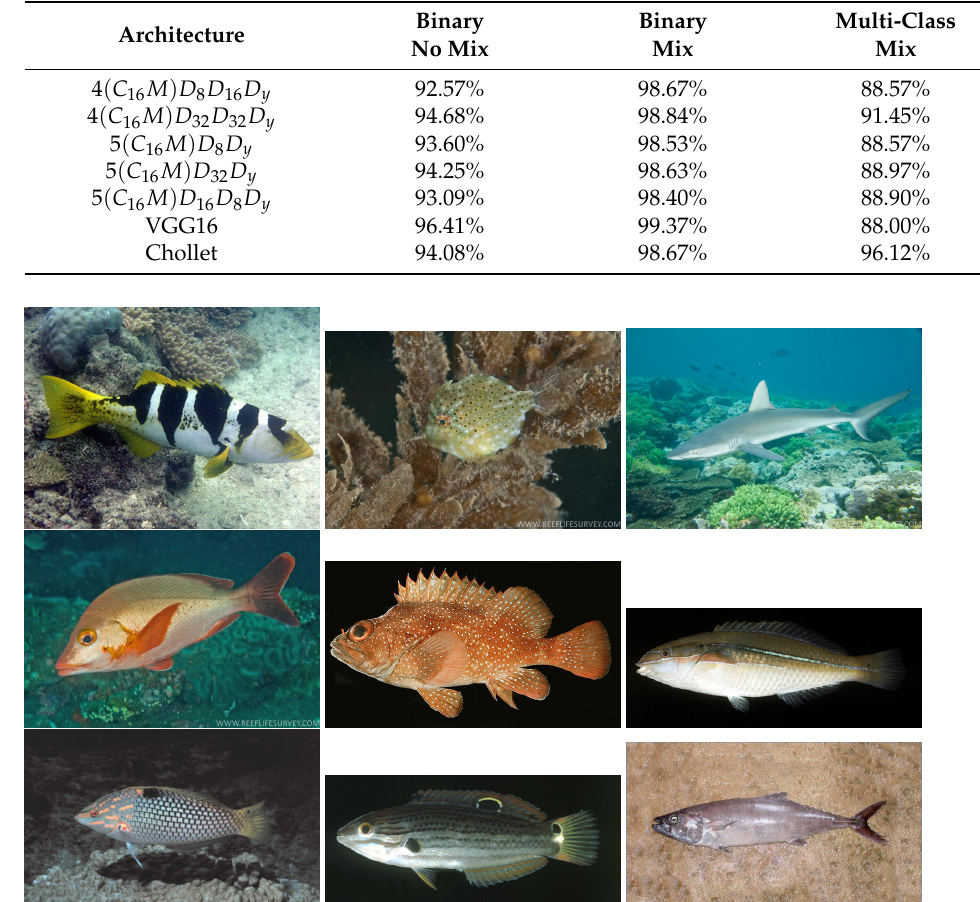
Figure 6. Images from the QUT dataset. Photo credit: QUT FISH Dataset, Fish Species Image Data, Sripaad Srinivasan, Fisheries Research Institute, CC BY-SA